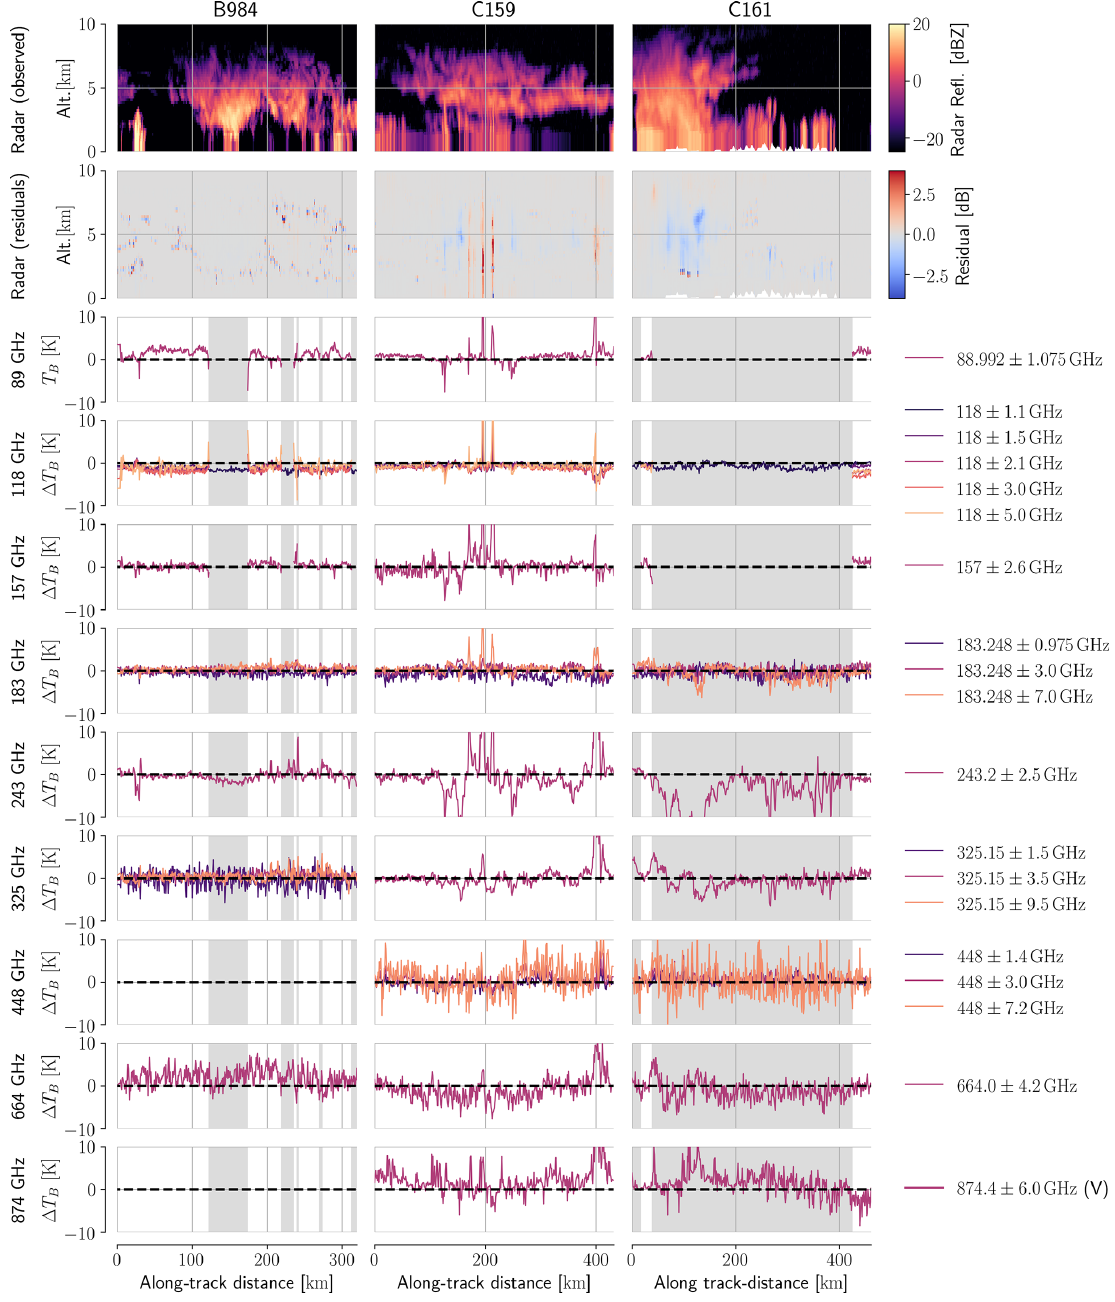
Figure 10. Differences between observed and fitted observations for the large plate aggregate particle. The first two rows depict the radar observations and their residuals, respectively. The following rows show the retrieval residual in the radiometer measurements for each of the frequency bands used in the retrieval. The grey shading marks sections of the flight path that were located over land